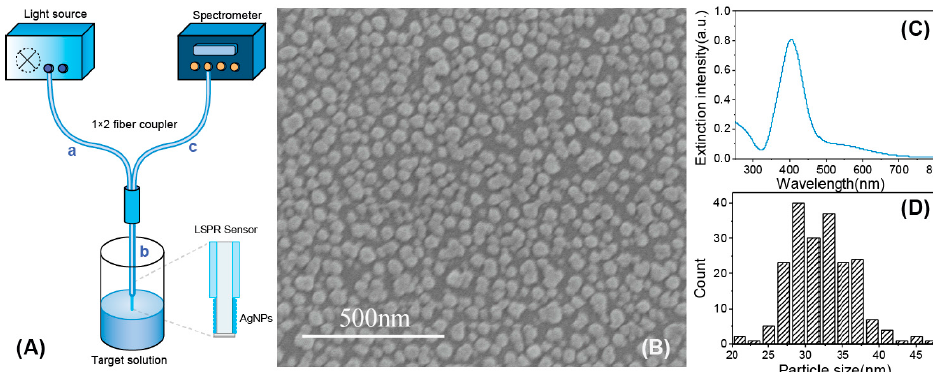
Figure 6. A summary scheme for the functionalization process of the AgNPs for biosensing appli- cations. Reprinted with permission of [26].